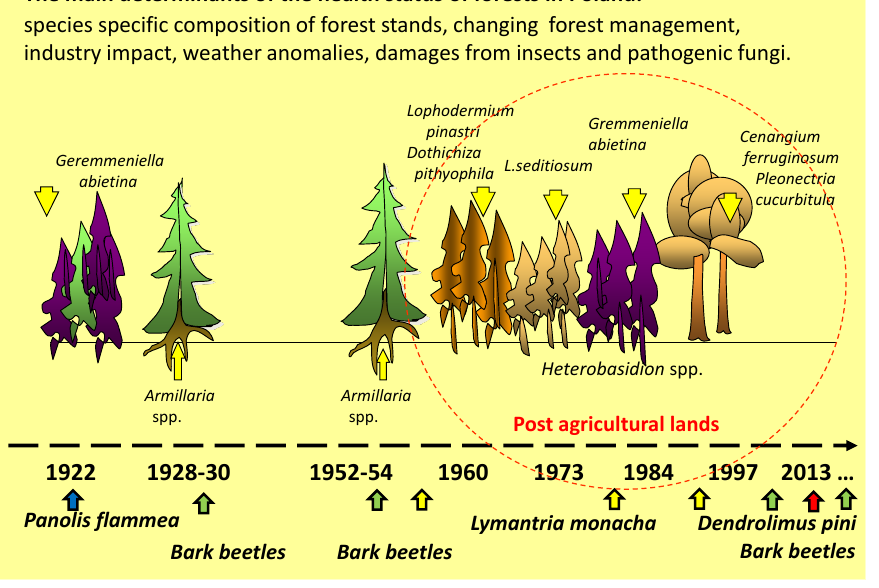
Figure 3. Main fungal diseases and insect pests causing forest mortality since 1922 in Poland